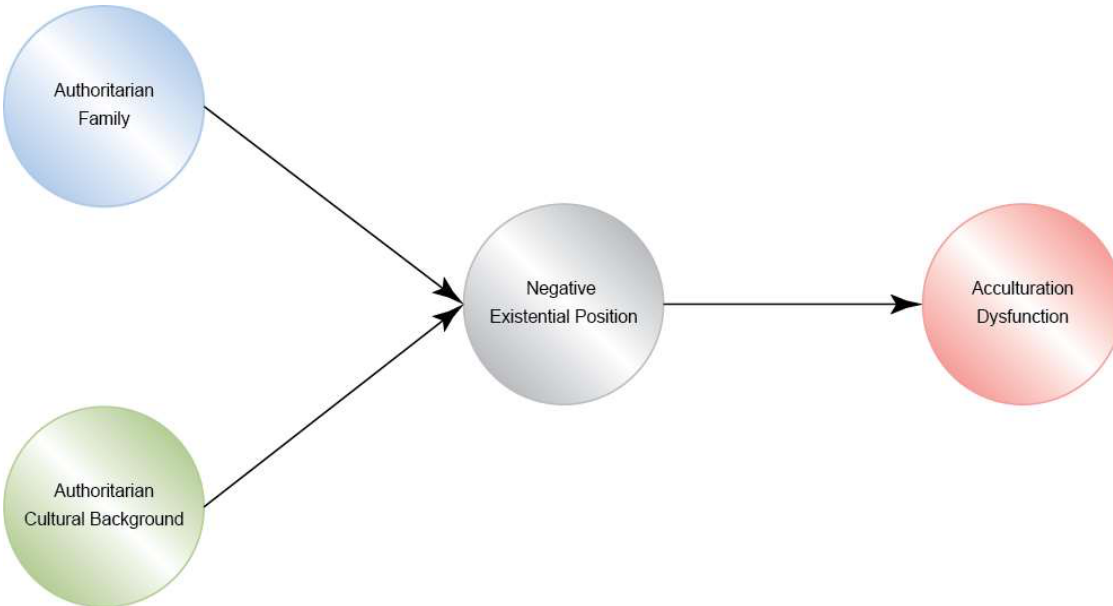
Figure 5: Acculturation Dysfunction predicted by the Negative Existential